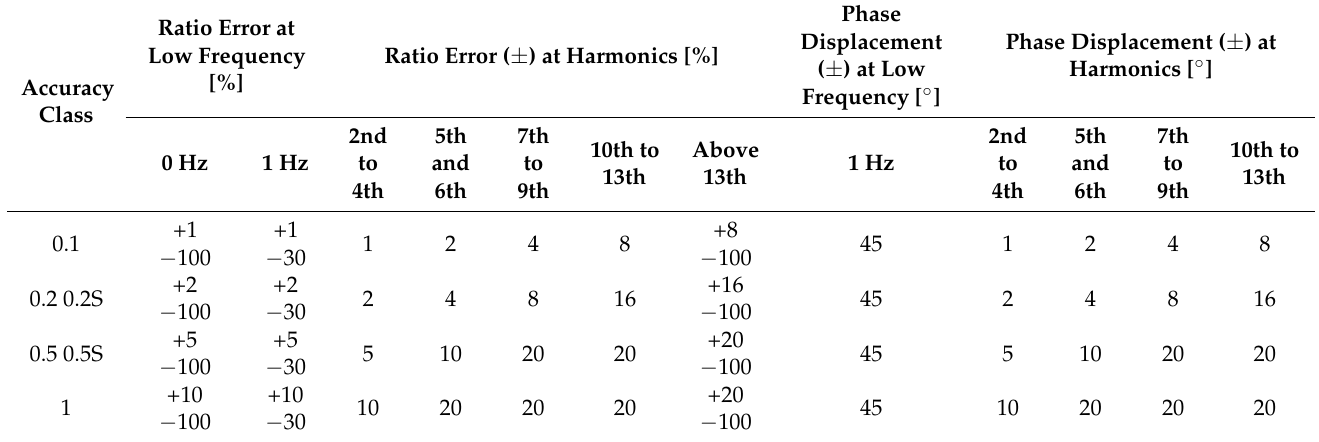
Table 1. Measuring accuracy classes